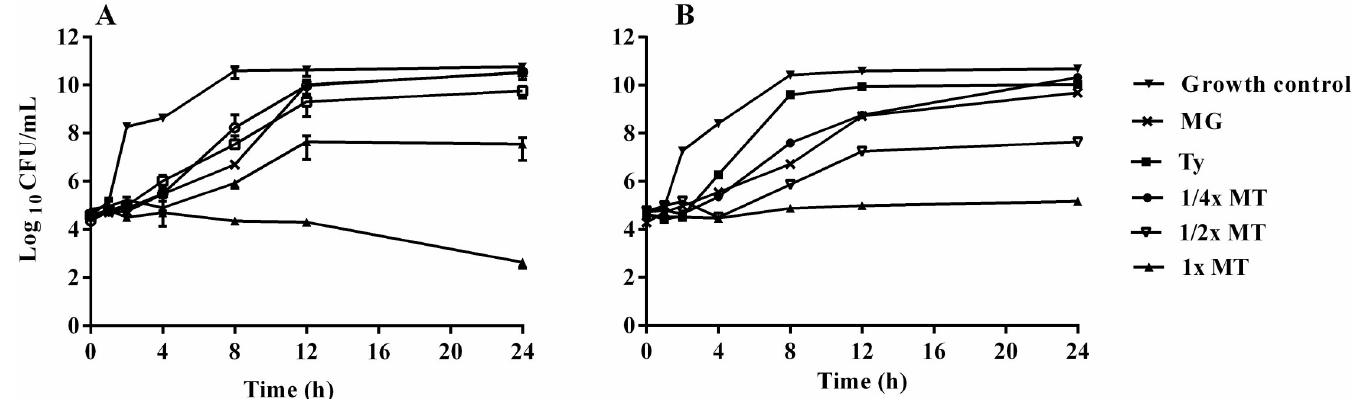
Fig 1. Time-kill curves of S . Typhimurium ATCC 14028 (A) and S . Typhimurium LVPP-STI15 (B) treated with methyl gallate (MG), tylosin (Ty) and various concentrations of their combination (MT). Plotted values represent mean ± SEM of at least six independent experiments. Growth control: non-treated S . Typhimurium. MG = 128 μ g/mL; Ty = 256 μ g/mL; ¼× MT = 32 μ g/mL MG and 64 μ g/mL Ty; ½× MT = 64 μ g/mL MG and 128 μ g/mL Ty; and 1 × MT = 128 μ g/mL MG and 256 μ g/mL Ty. Since there was no concentration-dependent difference in the killing activity of MG (32, 64 and 128 μ g/mL) and Ty (64, 128 and 256 μ g/mL), only the growth curves of the bacteria treated with the maximum concentrations of each agent are displayed.